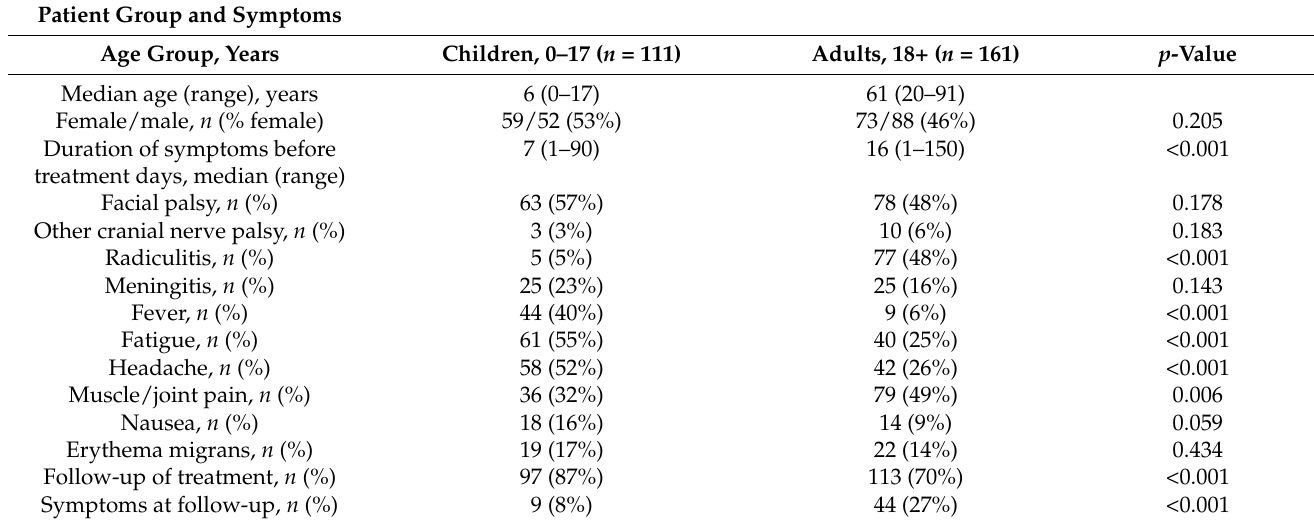
Table 1. Definite LNB cases divided by age and distribution of